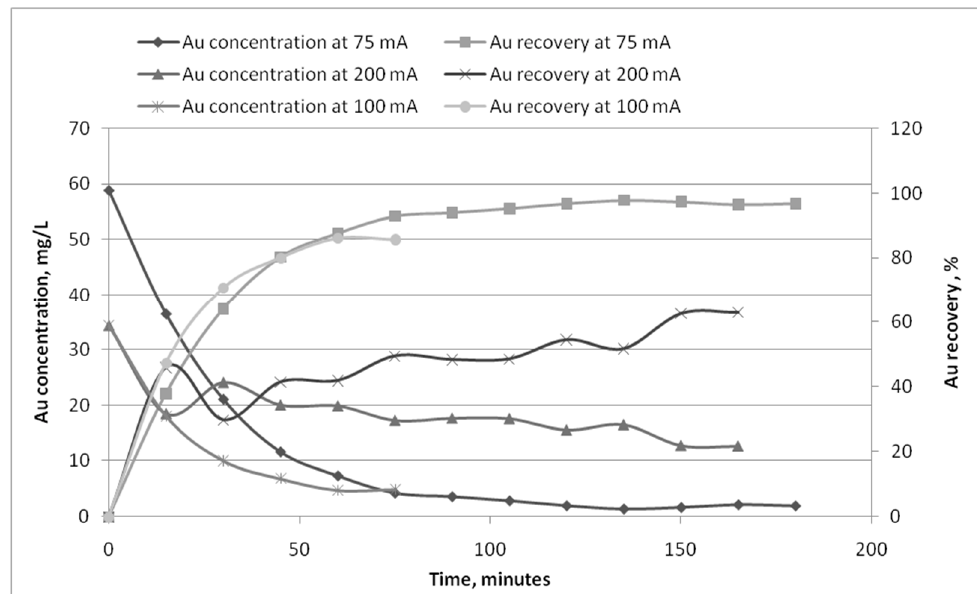
Figure 5. Evolution of Au concentration and recovery from solution at various current intensities vs. process time.